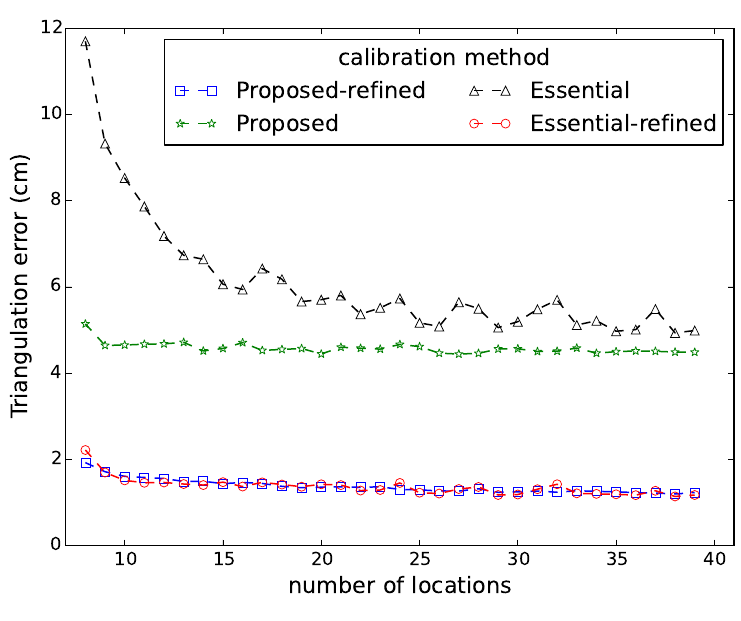
Figure 6. Triangulation error comparison between our method (proposed) and the method of Hödlmoser et al. [17] (essential) using different numbers of locations. Each location yields two calibration samples (head and feet).